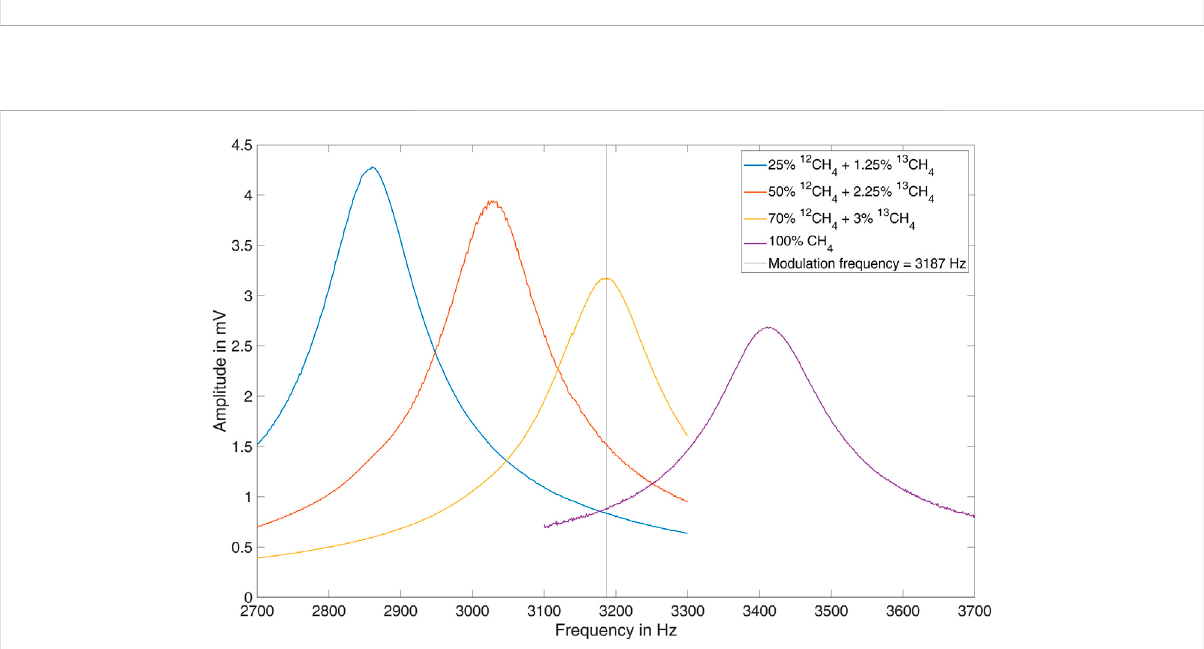
FIGURE 5 Photoacoustics signal as function of the modulation frequency for different